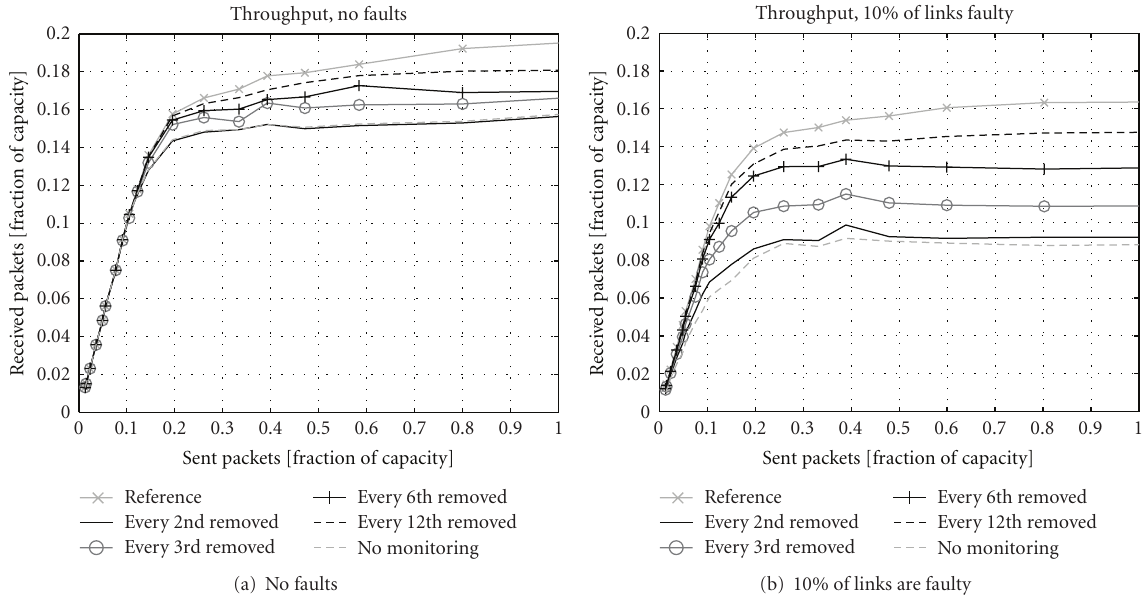
Figure 15: Throughput with fewer monitors. C size = 5 and data processing is